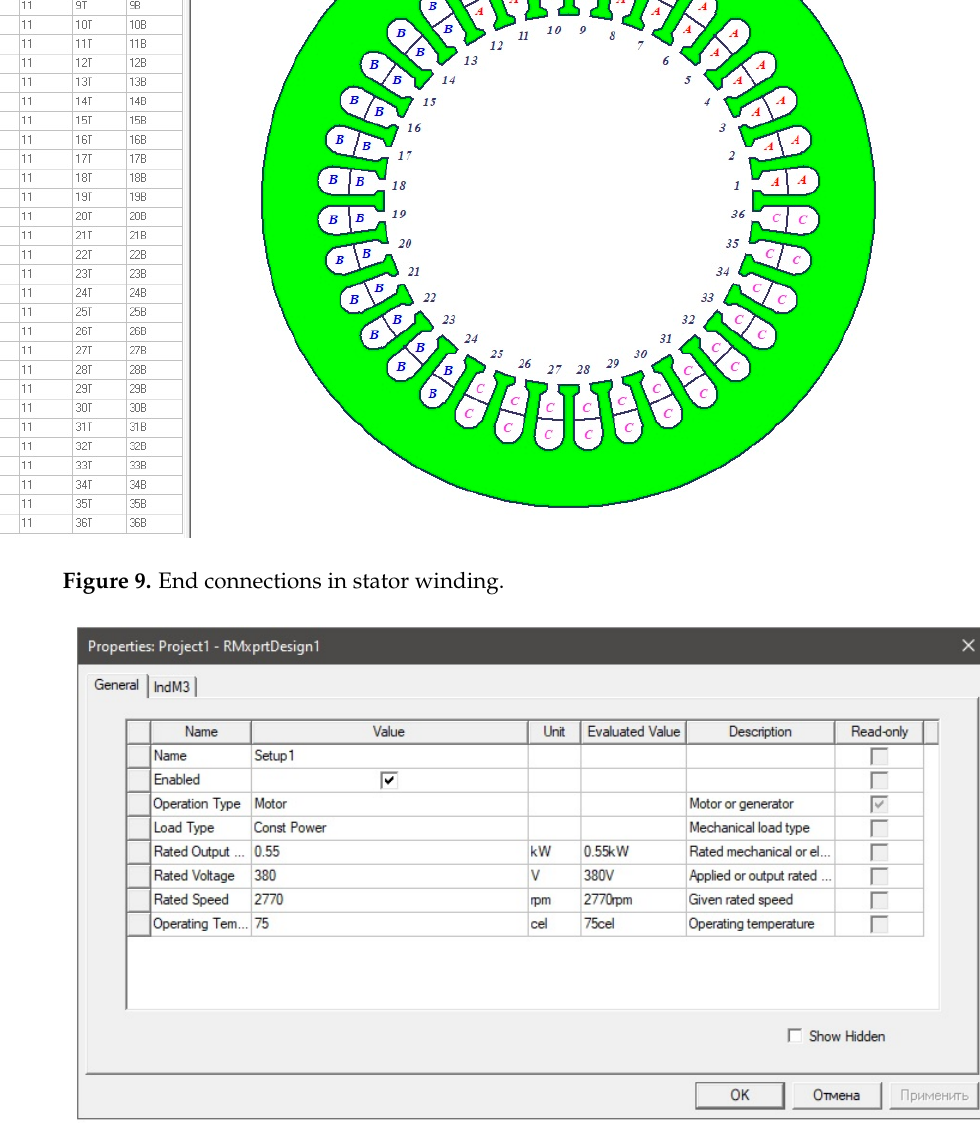
Figure 10. Solution Profile window. Table 1. Project calculation result window in tabular